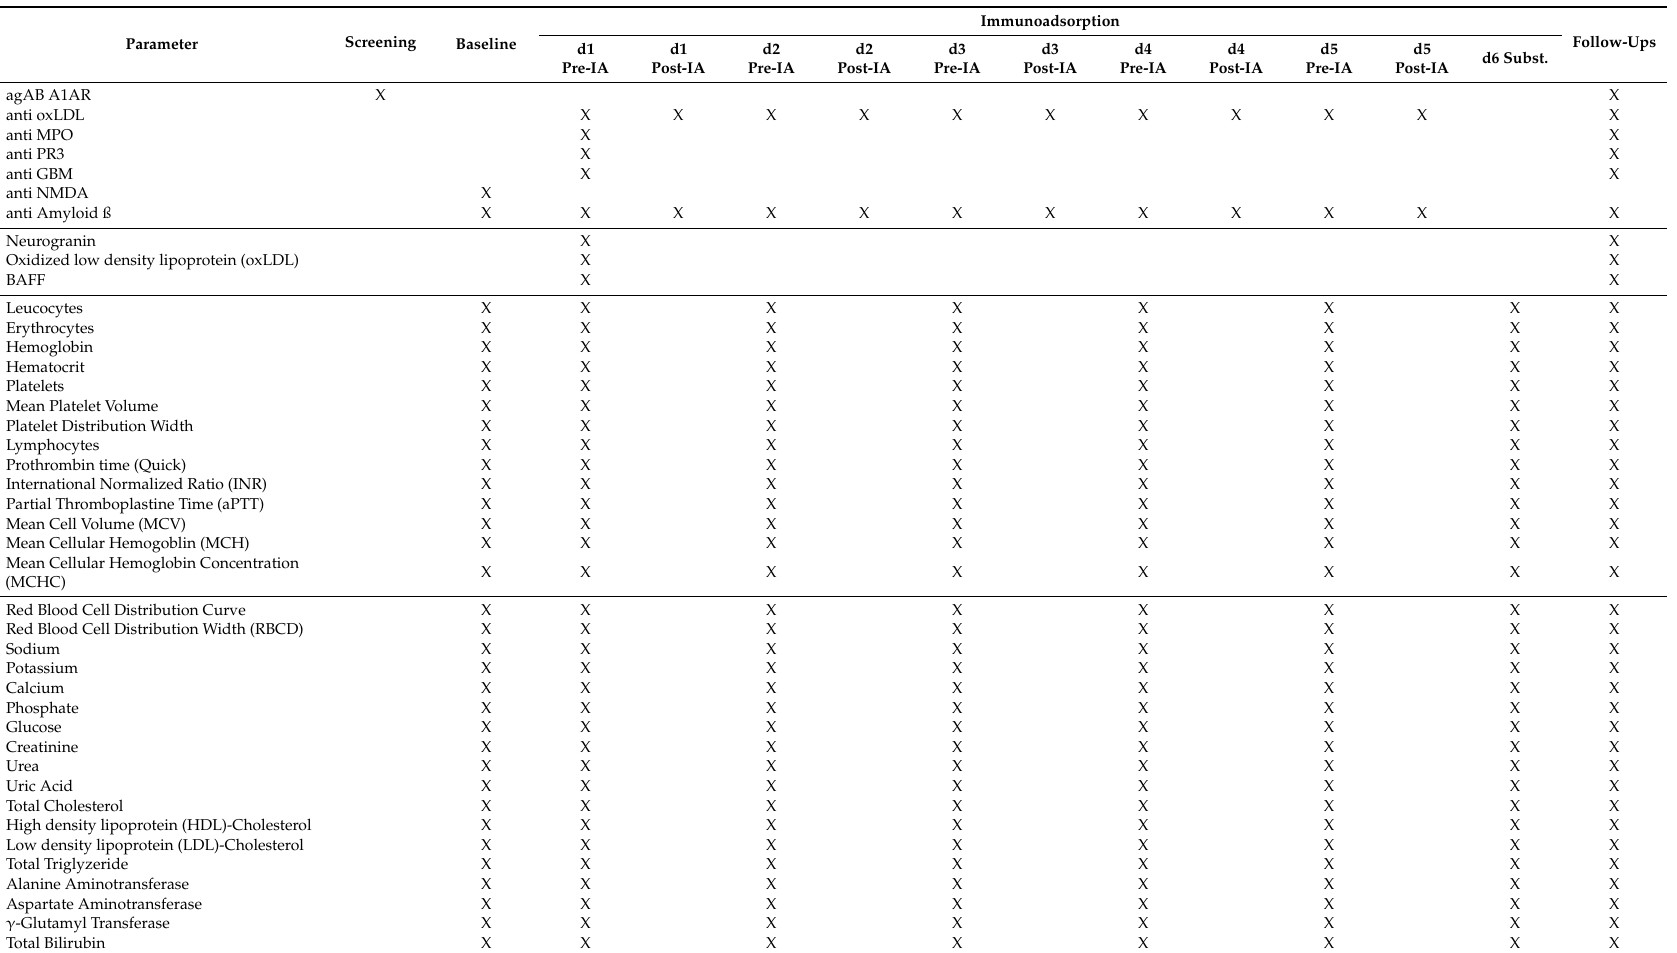
Table A1. Laboratory